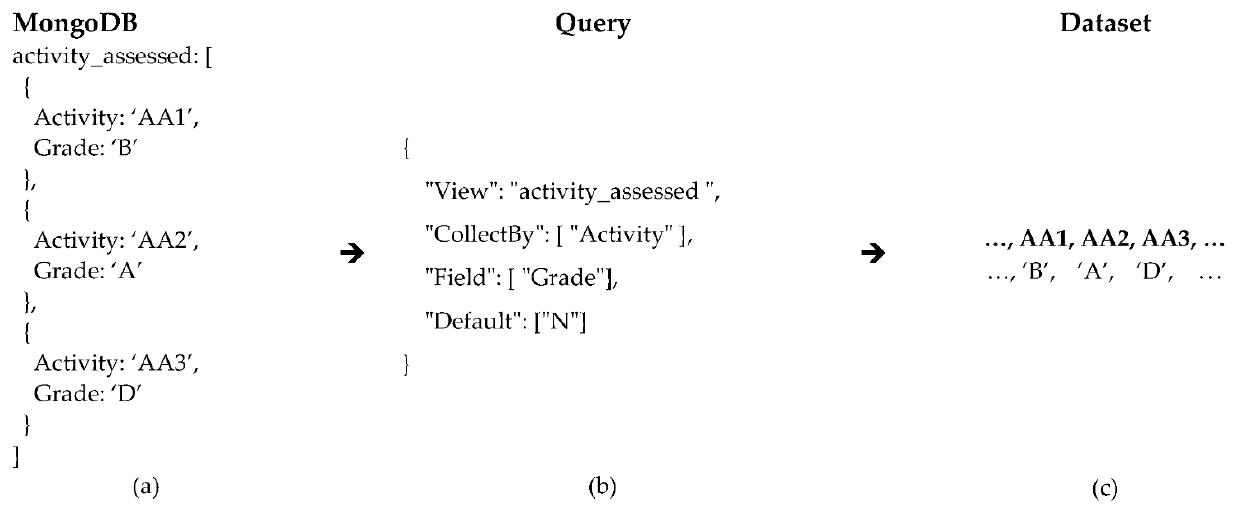
Figure 5. Example of creation of a dataset from a query where ( a ) shows the data stored in the MongoDB, ( b ) defines the query to create the dataset for training a predictive model, and ( c ) shows the obtained dataset from data in MongoDB.